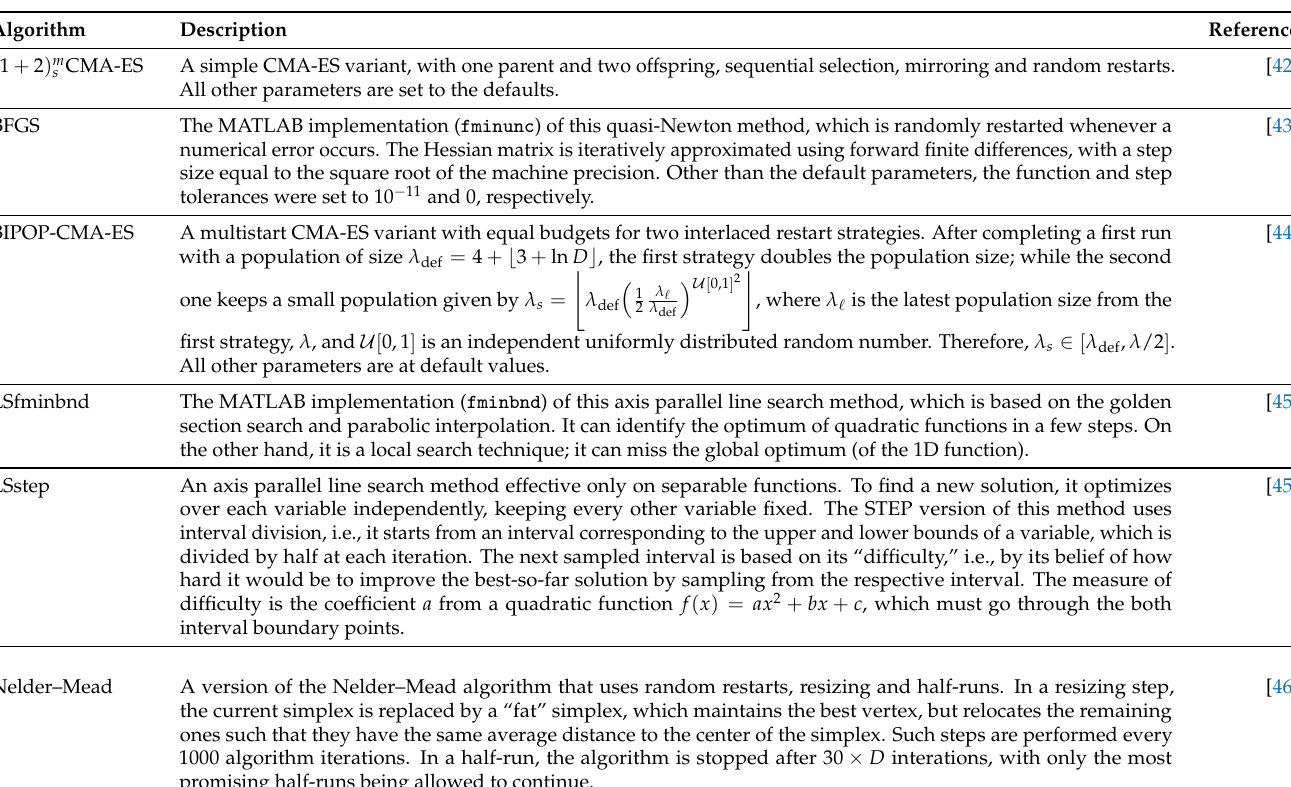
Table 2. Summary of the algorithms employed in this paper, which were selected using ICARUS [41] and the publicly available results from the BBOB sessions at the 2009 and 2010 GECCO Conferences. Algorithm names are as used for the dataset descriptions available at http://coco.gforge.inria.fr/doku.php?id=algorithms